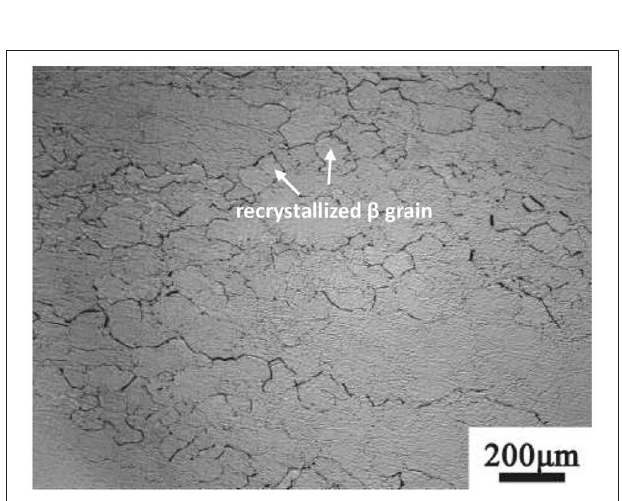
FIGURE 7 | The microstructure of Ti-25.5Al-13.5Nb-2.8Mo-1.8Fe alloy deformed at 1,050 ◦ C/0.001 s − 1